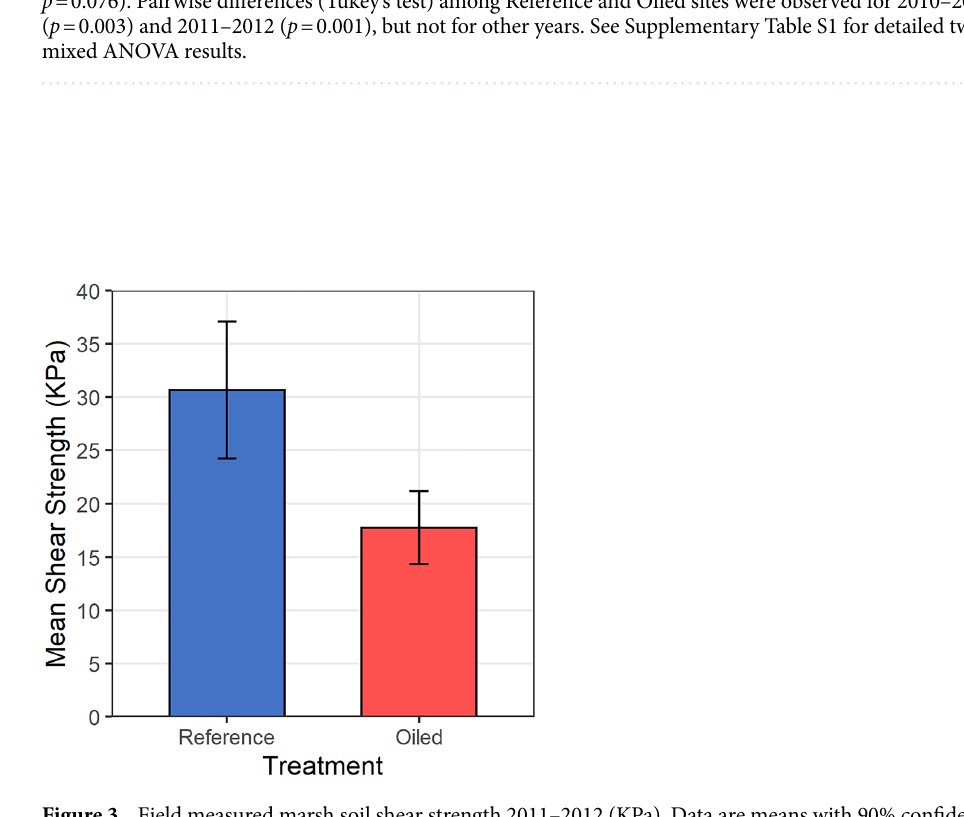
Figure 3. Field measured marsh soil shear strength 2011–2012 (KPa). Data are means with 90% confidence intervals, n = 4 for Reference and 13 for Oiled sites. Soil shear strength differences were observed among the Reference and Oiled sites (t 6.29 = − 3.877, p = 0.007, Welch’s t-test). See Supplementary Table S2 for further